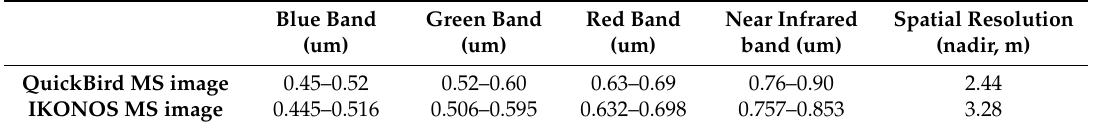
Table 1. Comparison between the bandwidth and spatial resolution of QuickBird and IKONOS